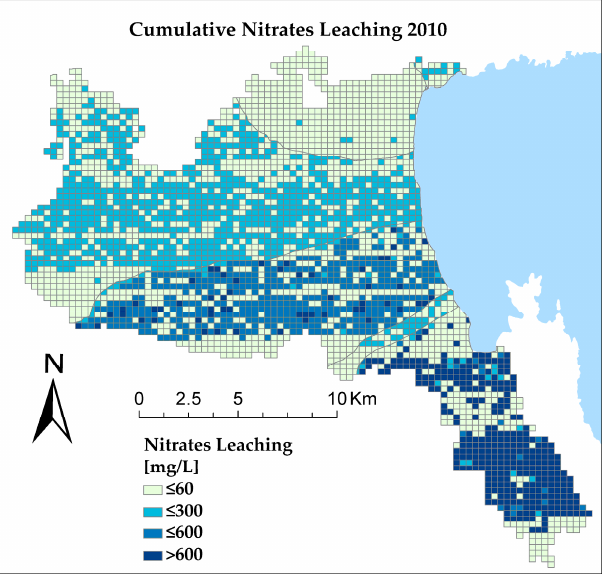
Figure 15. Simulated cumulative nitrates leached into the aquifer for the year of 2010.